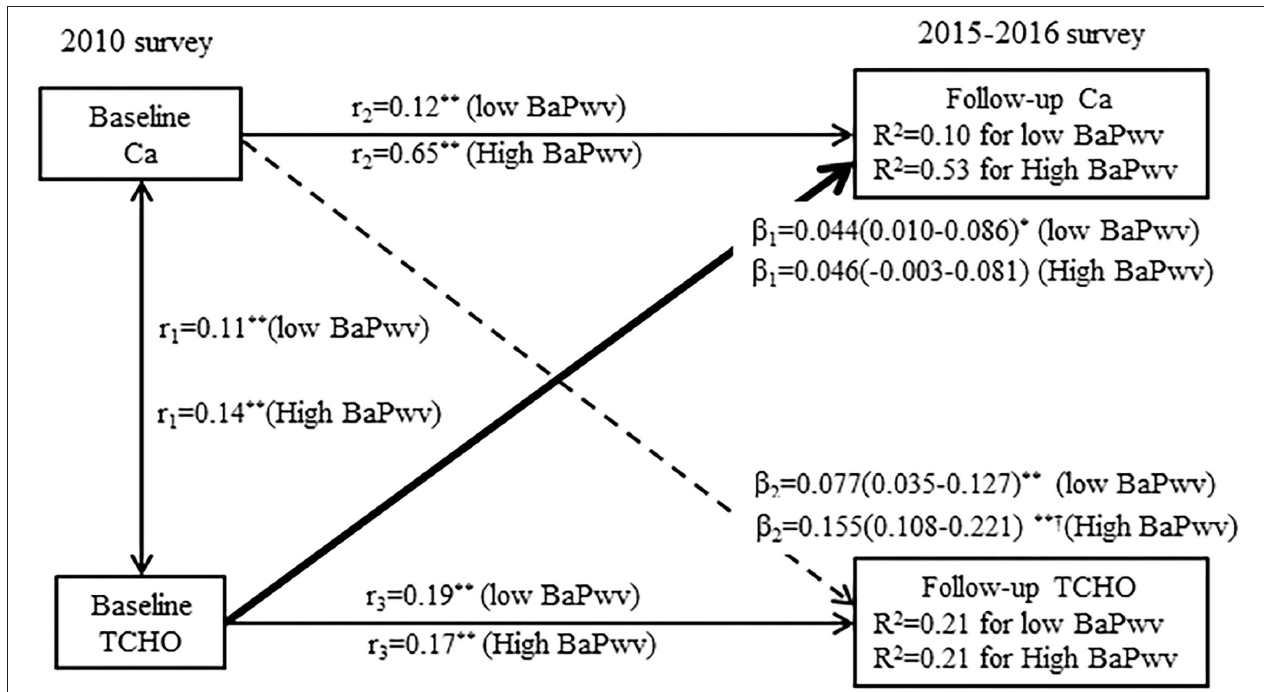
FIGURE 3 | A cross-lagged path analysis of serum calcium and total cholesterol in the low baPWV group and high baPWV group, adjusted for the covariates (covariates included age, sex, BMI, smoking, alcohol consumption, regular exercise, marriage, caloric intake, family history of CVD, TG, HDL-C, LDL-C, and drug use for hypertension or dyslipidemia) in the total sample ( N = 3,292); β 1 and β 2 are cross-lagged path coefficients, r 1 represents the synchronous correlations, r 2 and r 3 represent tracking correlations, R 2 variance explained. ** P < 0.001 for coefficients being different from 0. † difference between β 1 and β 2 for being different from 0.